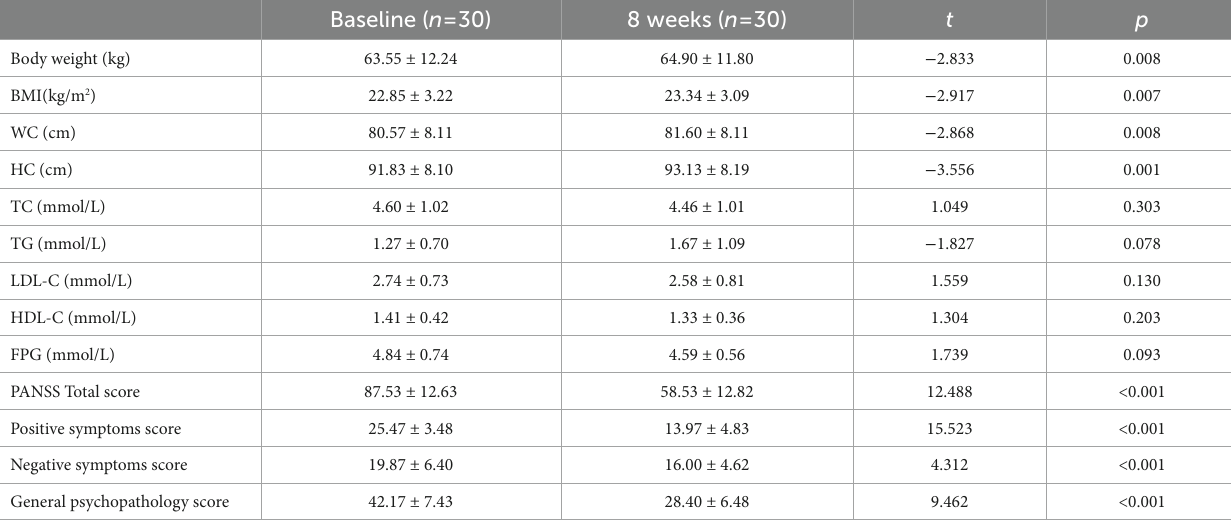
TABLE 1 Anthropometric, metabolic and psychiatric outcomes in drug-naive patients with schizophrenia at baseline and after 8 weeks of treatment with risperidone.